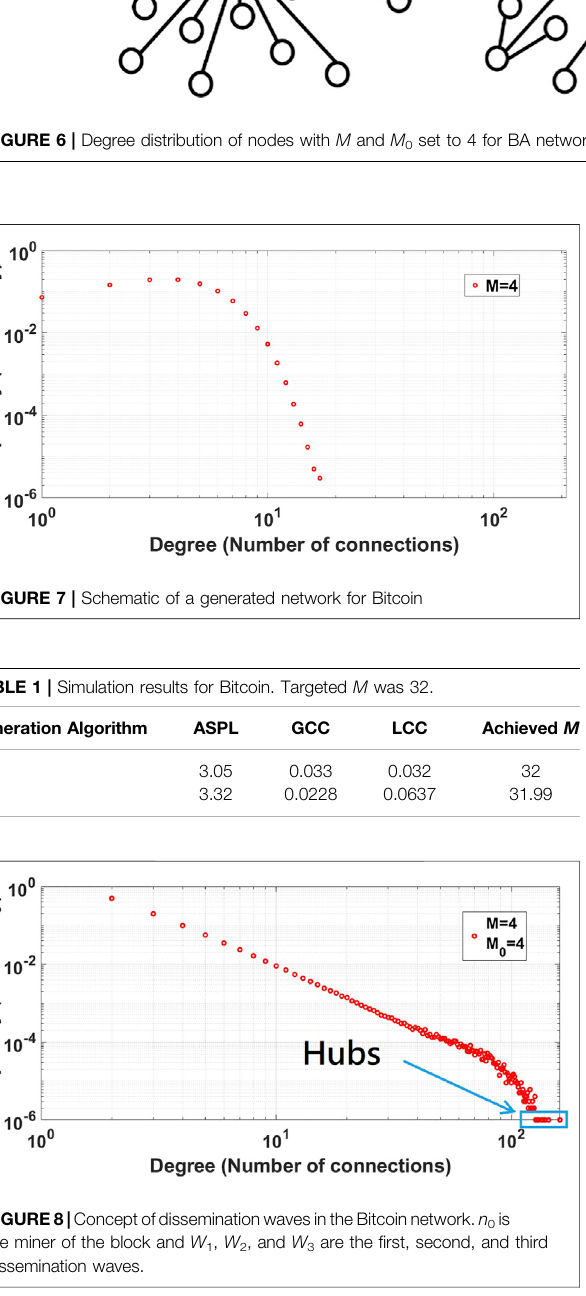
Frontiers in Blockchain |